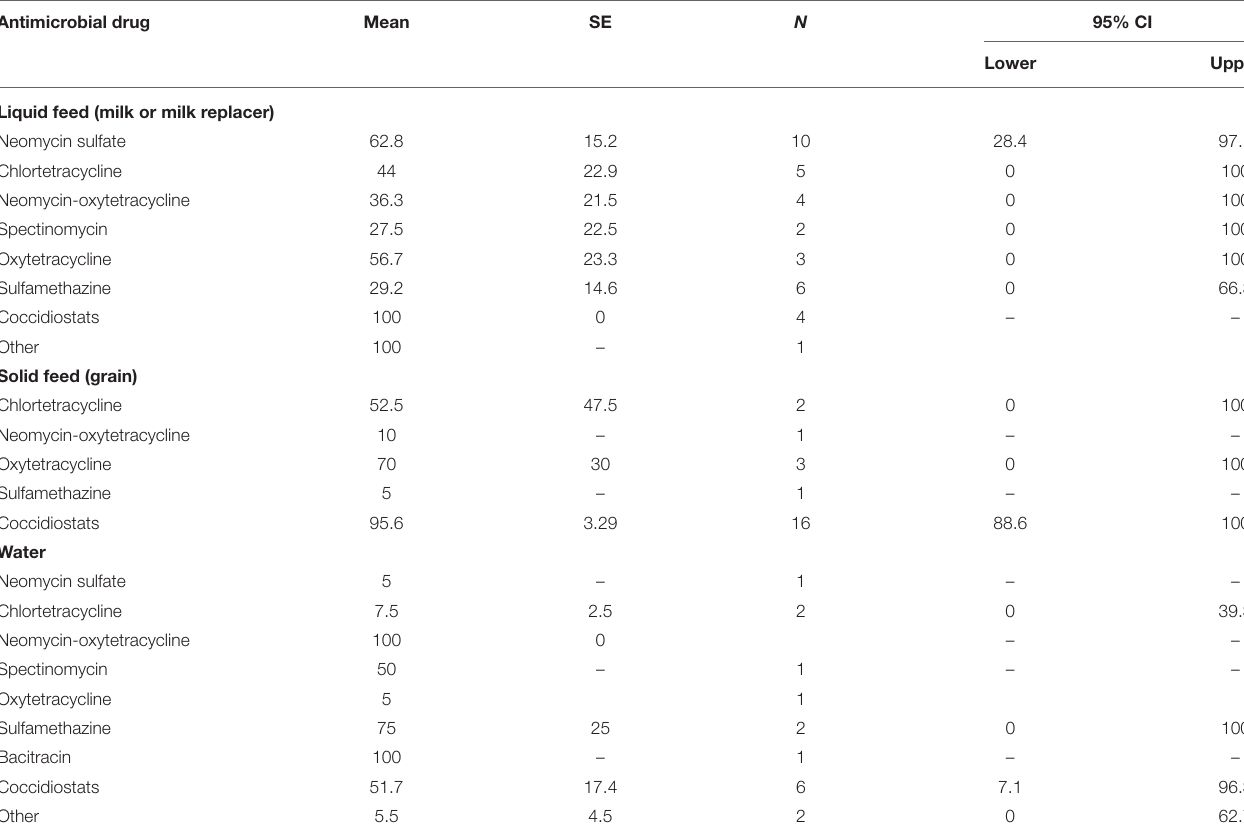
TABLE 6 | Mean percentage of preweaned dairy calves receiving antimicrobial therapy between birth and weaning with different antimicrobial drugs. Antimicrobial drug